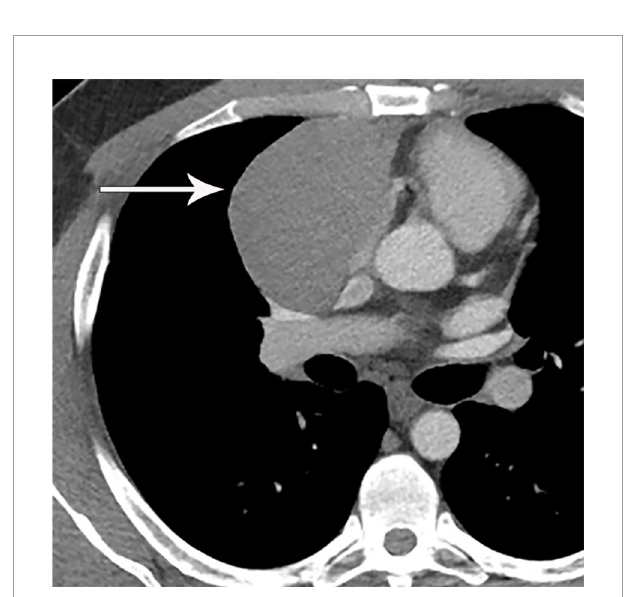
FIGURE 9 | 32 year old man with thymoma and myasthenia gravis. Contrast-enhanced CT shows right prevascular mediastinal mass (arrow).